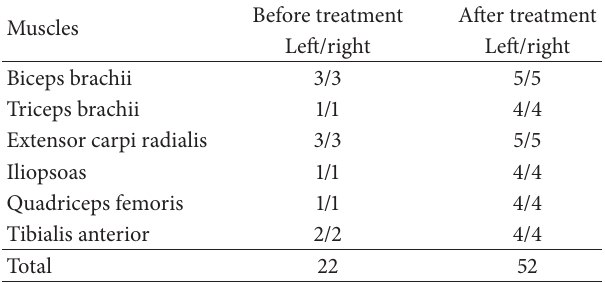
Table 1: Compromise of muscular force in the lower limbs by Medical Research Council